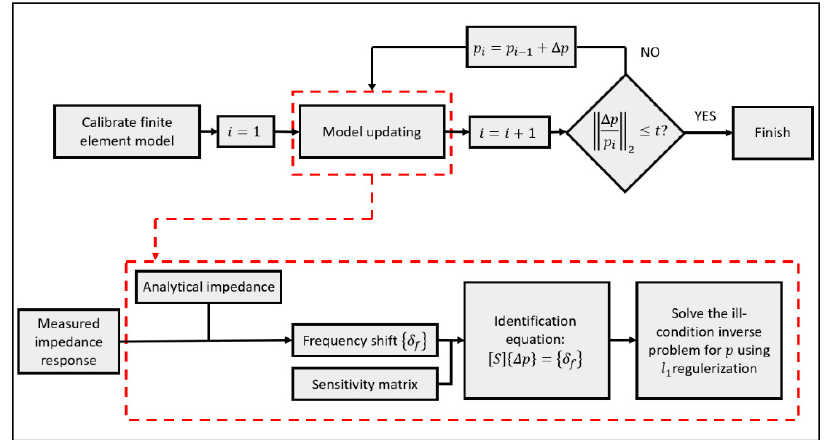
Figure 2. The flowchart of the proposed damage quantification approach